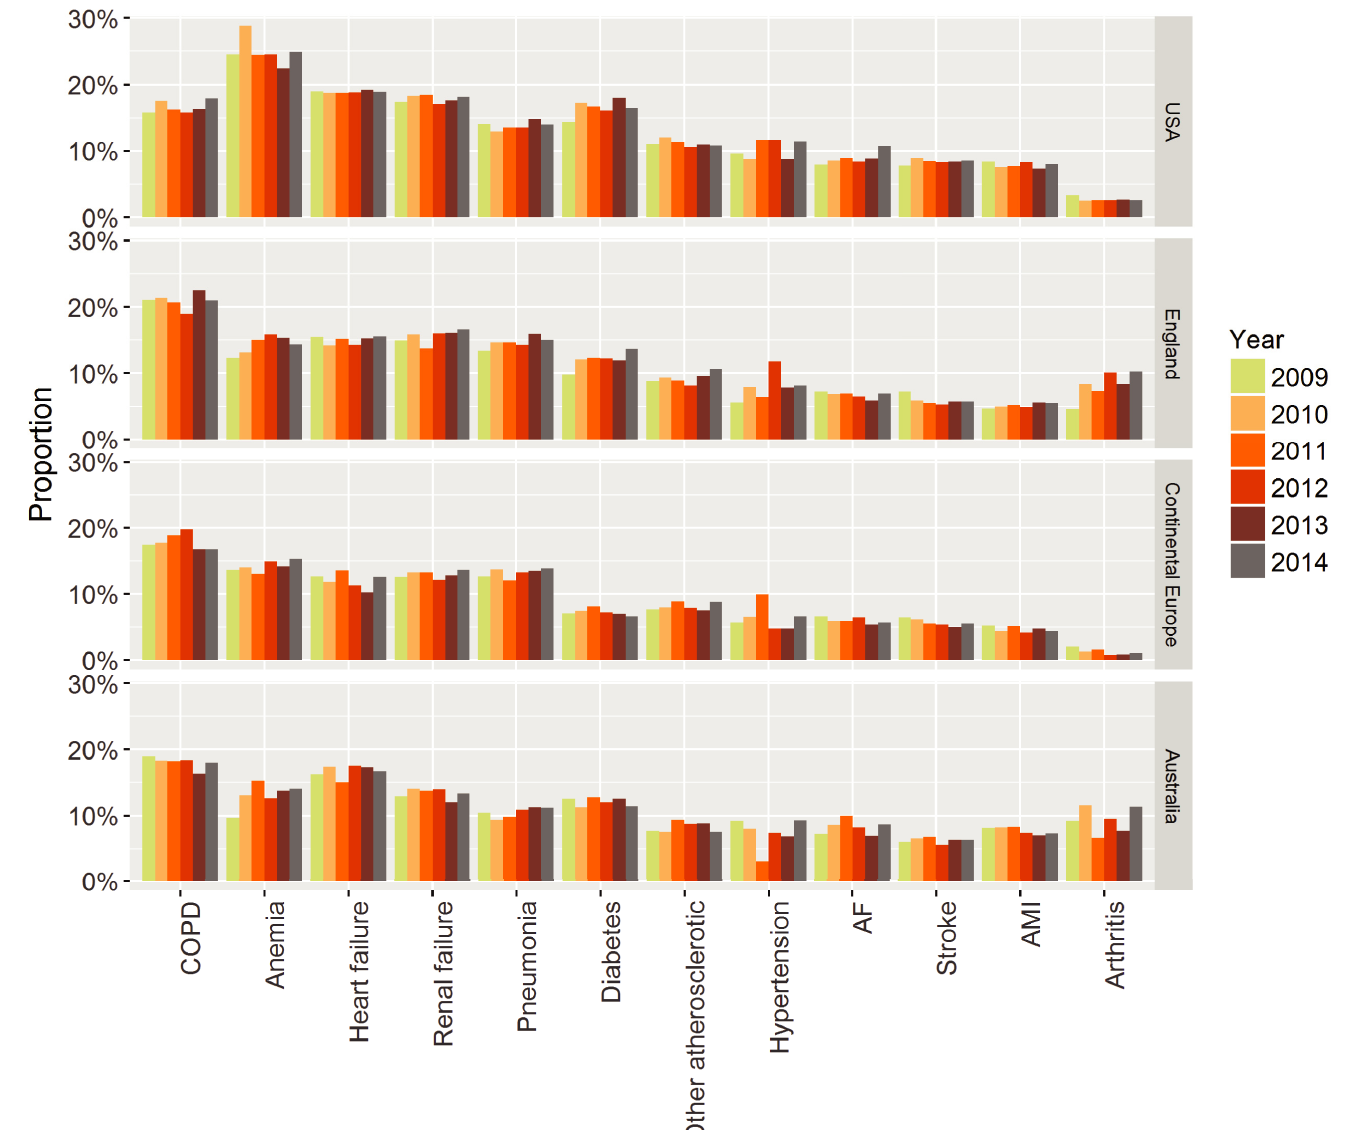
Fig 2. Proportion of readmissions over time in different countries for each of the 12 chronic conditions. Abbreviations: AF atrial fibrillation; AMI acute myocardial infarction; COPD chronic obstructive pulmonary disease.